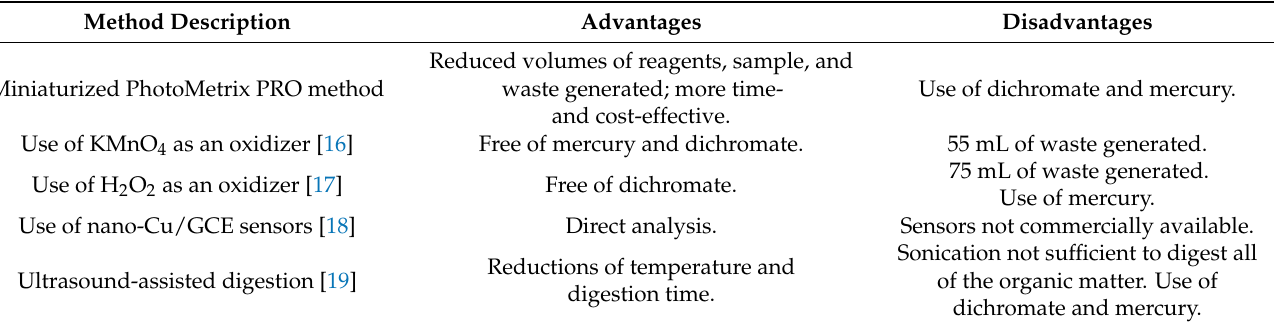
Table 5. Advantages and disadvantages of some modified methods for COD